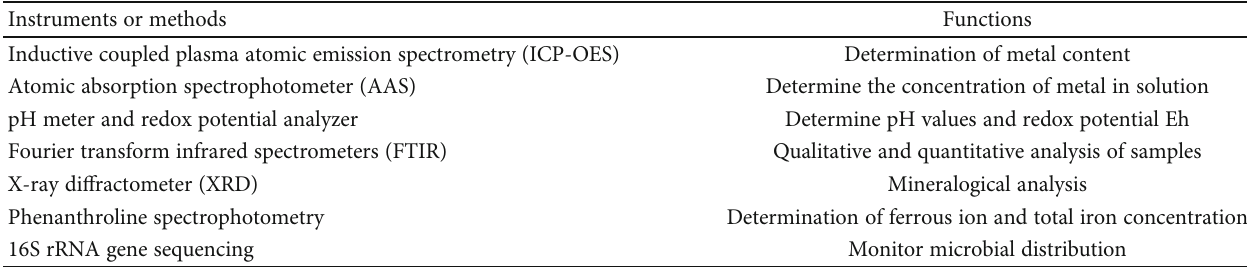
Table 2: Experimental equipment and functions commonly used in biological leaching